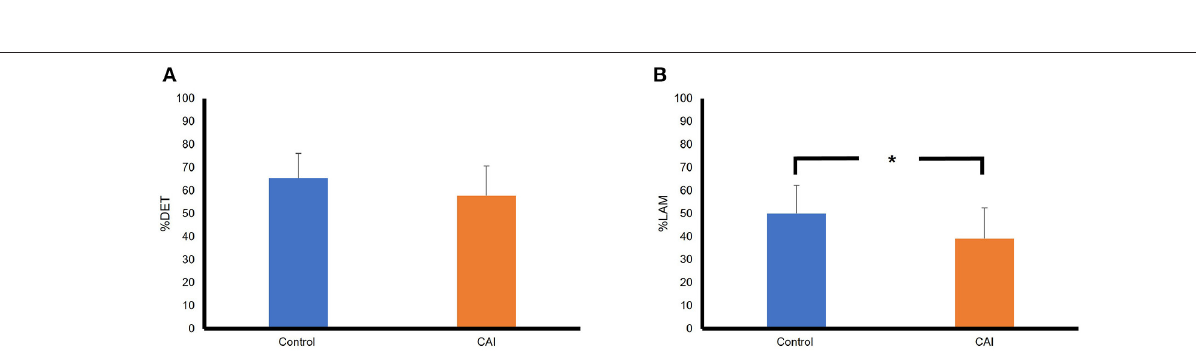
FIGURE 3 | Recurrence plots of an example participant with CAI (A) and healthy control (B) in the sagittal plane. CAI, chronic ankle instability.